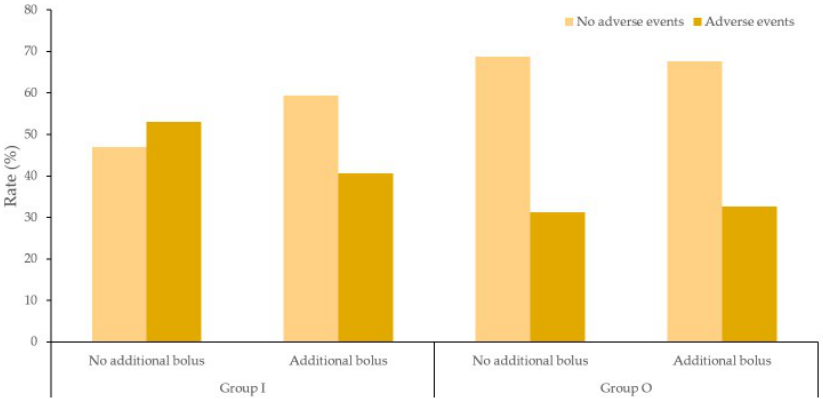
Figure 5. The comparison of adverse events occurrence with additional bolus and without addi- tional bolus in each group.